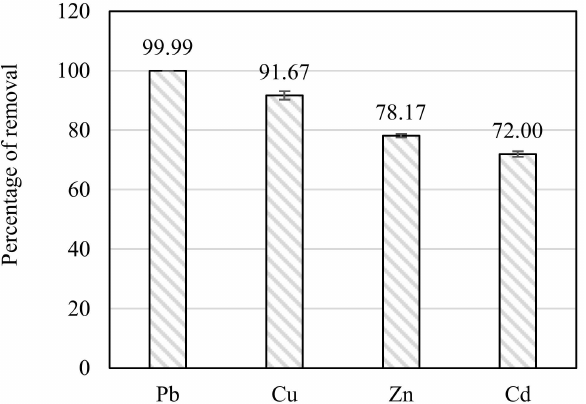
Figure 5. Results of the removal percentage of the heavy metals using